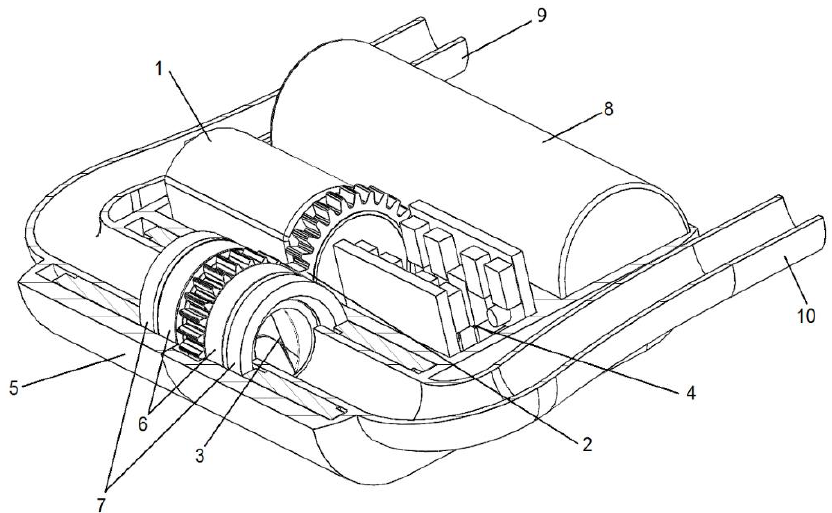
Figure 2. The implantable system of the device—section through the housing. Legend: 1: motor, 2: mechanical transmission, 3: pump rotor, 4: electronic circuit, 5: housing, 6: bearings, 7: sealing ele- ments, 8: battery, 9: outflow cannula, 10: inflow cannula.